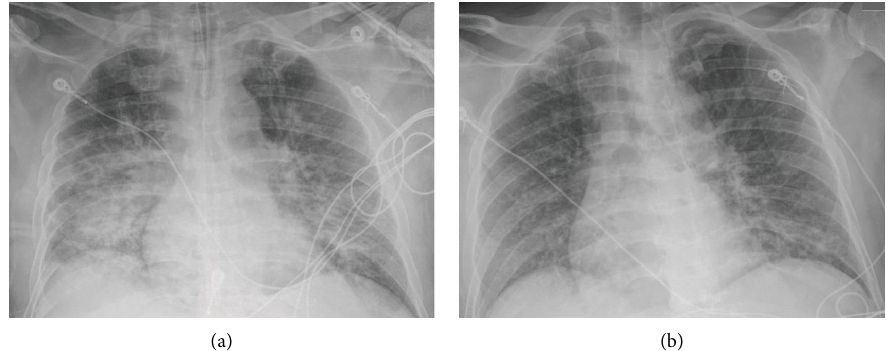
Figure 2: Chest X-rays. Chest X-ray (CXR) which was taken 2.5 hours after intubation (day 2) showed signifcant difuse bilateral opacities. (a) CXR next day after extubation (day 7) showed improved bilateral opacities.